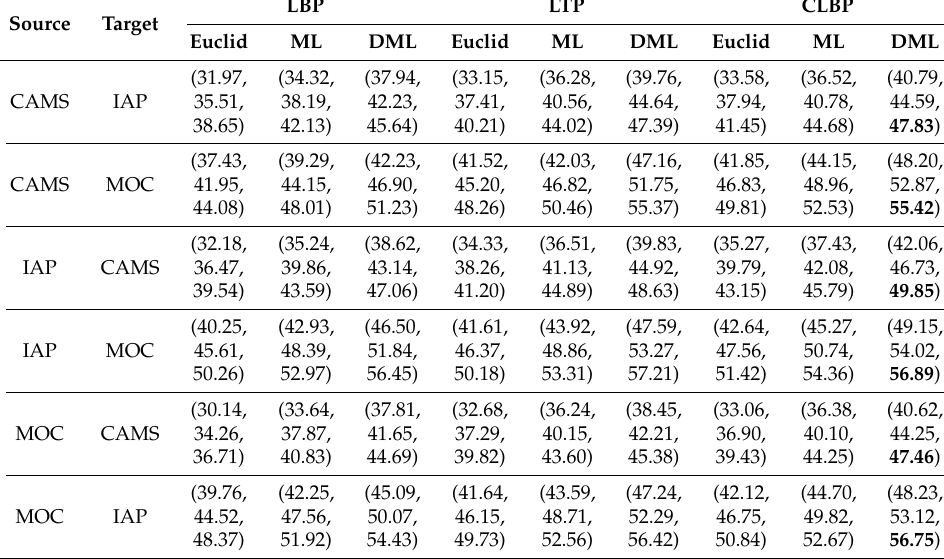
Table 4. Cross-domain classification accuracies (%) of local features with different metrics. The three accuracy numbers in a triple are the basic classification accuracy, the recognition accuracy after IGC, and after FN,